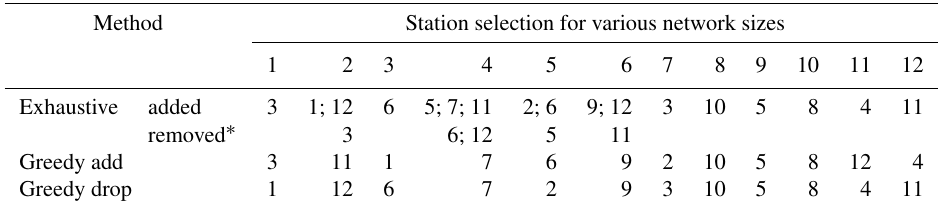
Table 5. Resulting station selections for the artificially permuted dataset with 860 data points. Method Station selection for various network